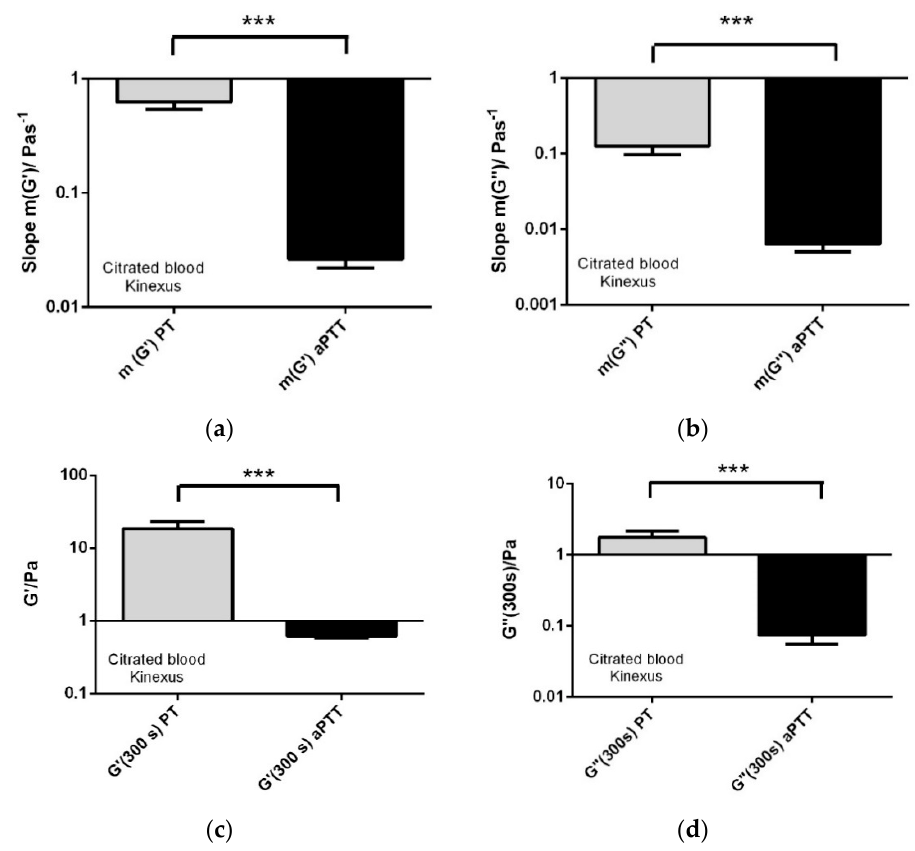
Figure A6. Comparison between extrinsic and intrinsic assays determined with the oscillatory rheometer ( n = 10). The asterics above the bars indicate that this particular bar is significantly different from all others. The linear slopes of elastic ( a ) and viscous ( b ) shear moduli of PT were significantly steeper than for aPTT. Similarly, the clot firmess, described by ( c ) the elastic and ( d ) the viscous shear moduli at 300 s were significantly stronger, i.e., higher, for PT than for aPTT measuremets. *** p < 0.001.